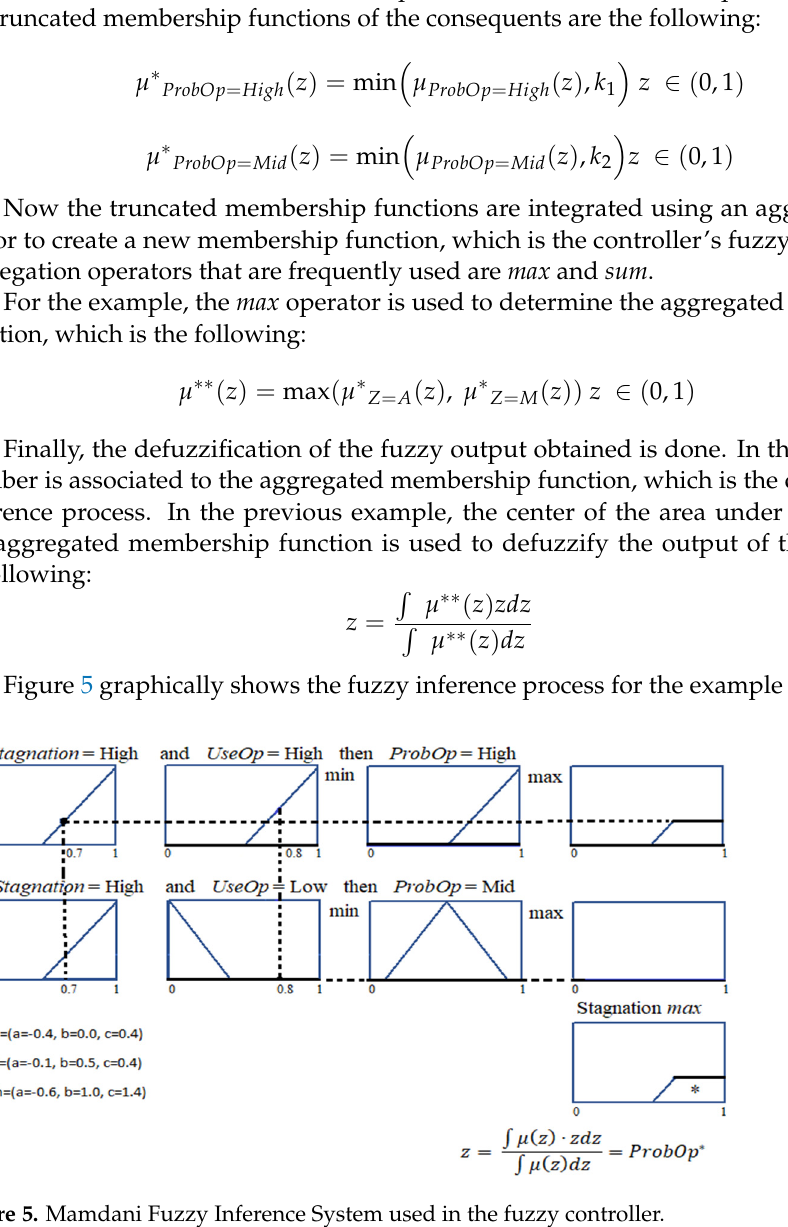
Table 2. Fuzzy controller